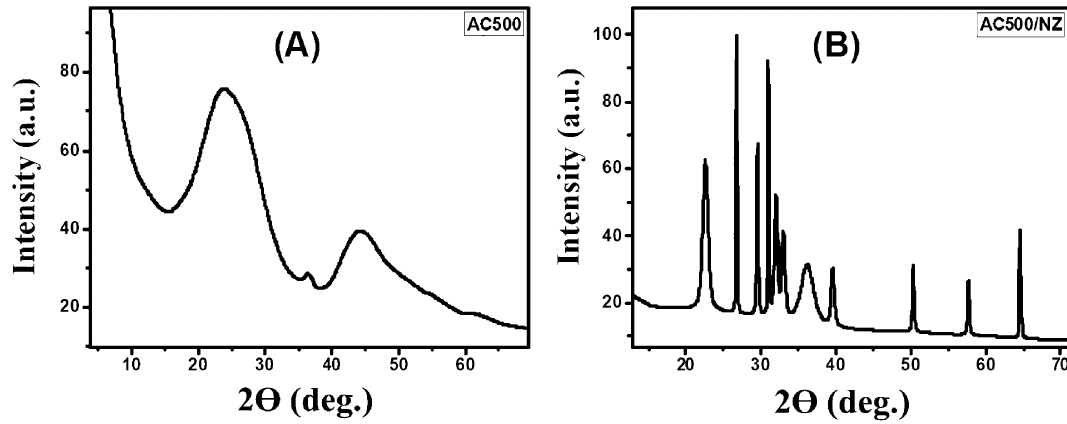
Figure 2. XRD patterns of ( A ) AC500 and ( B ) AC500/NZ.